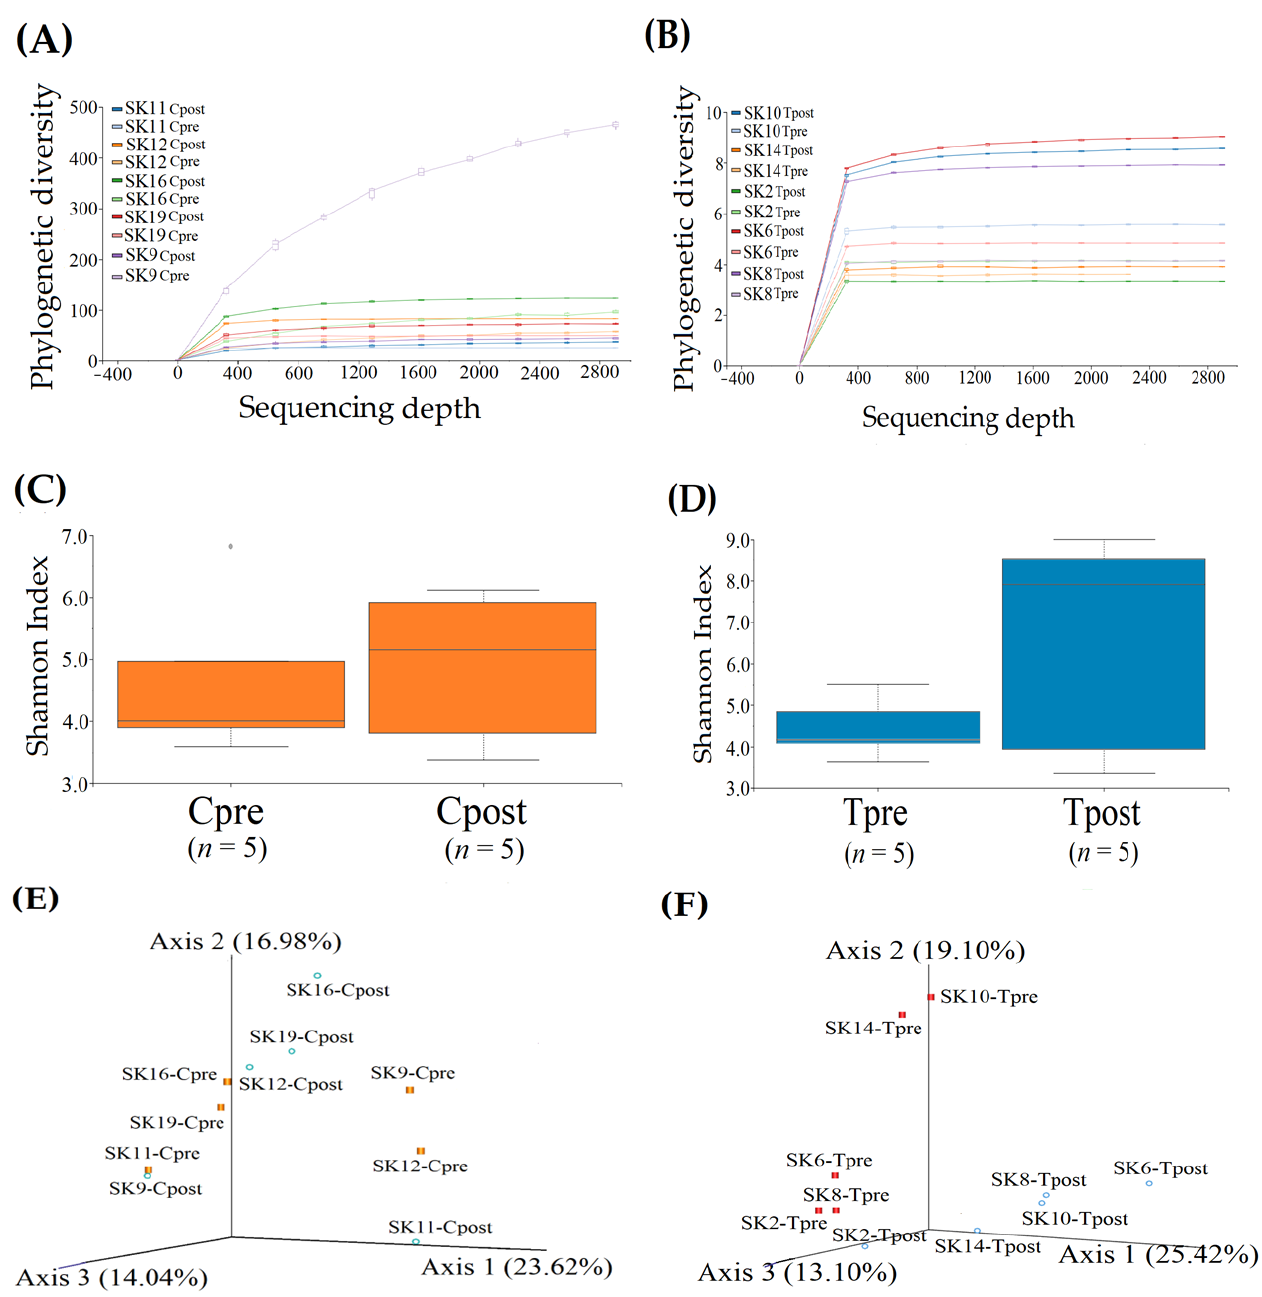
Figure 1. Refraction analysis for the pre-and post-samples of the control and treatment groups. The rarefaction curves of the phylogenetic diversity were computed and displayed for the control ( A ) and treatment ( B ) samples. Shannon H-index alpha diversity of the control ( C ) and treatment ( D ) samples. Comparison of similarity and dissimilarity for the control ( E ) and treatment ( F ) samples using PCoA represent unweighted unifrac distances.